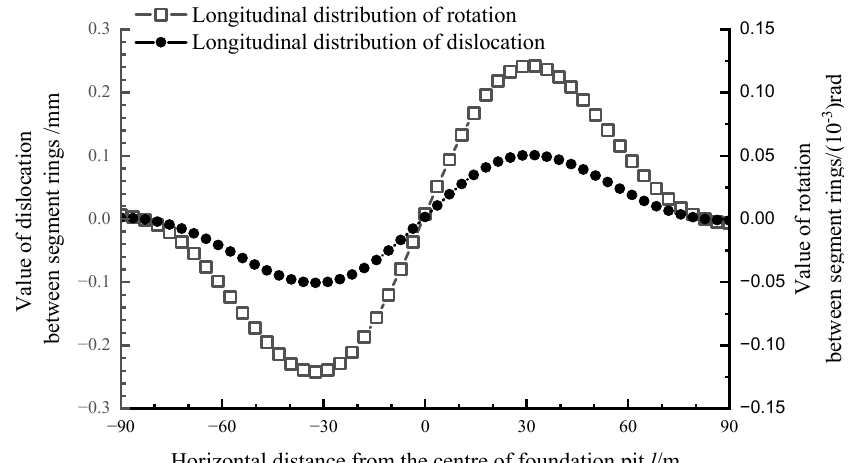
Figure 9. Comparison of the calculated and measured values of the horizontal displacement of the tunnel beside the foundation pit in case 2.